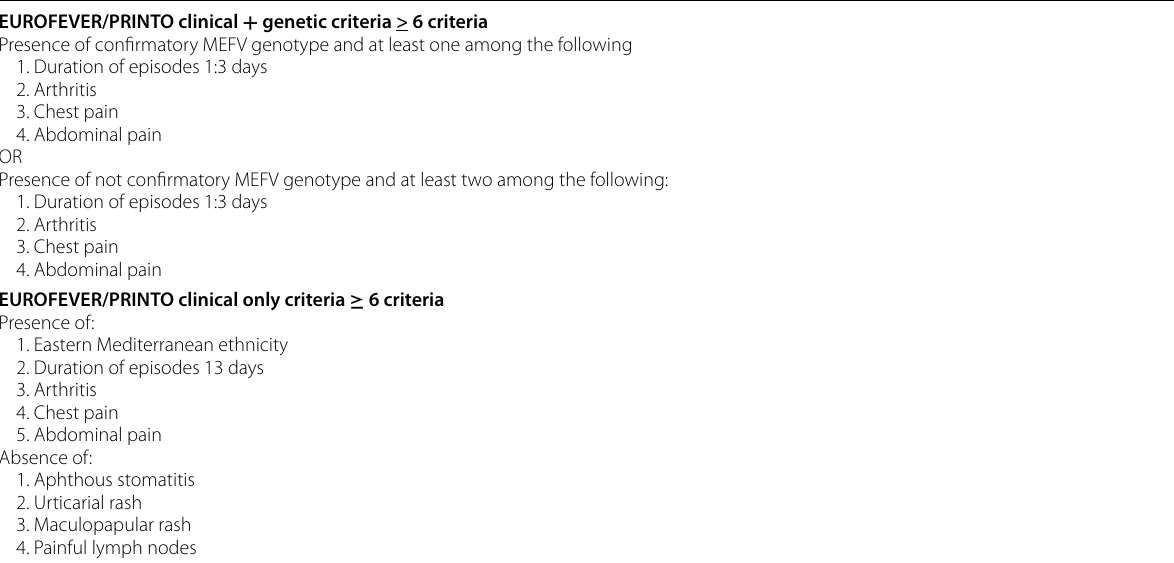
FMF familial Mediterranean fever, MEFV Mediterranean fever, PRINTO Paediatric Rheumatology INternational Trials Organization